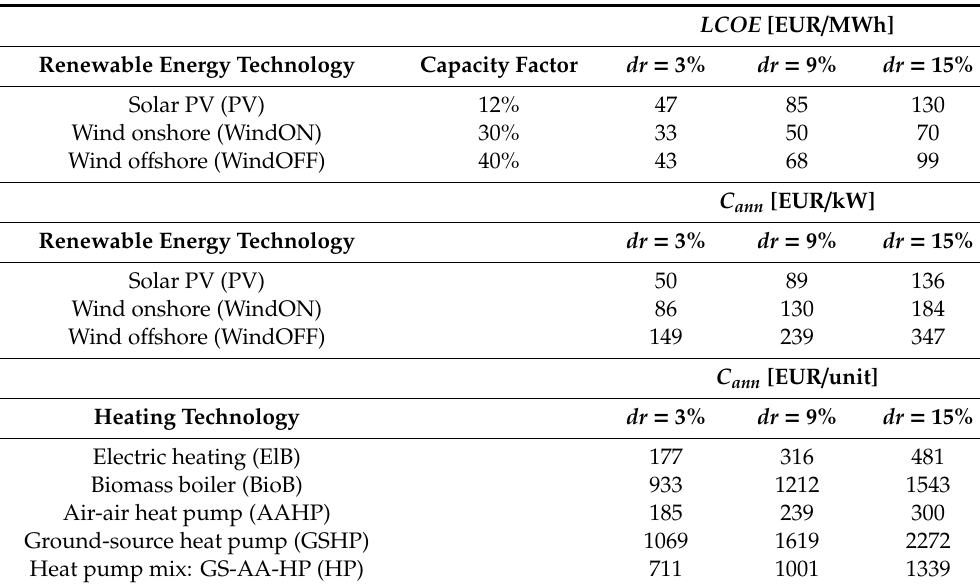
Table 3. LCOE , C ann for PV, WindON, and WindOFF; C ann for ElB, BioB, and HP (calculations based on 2020 technology cost parameters as provided by the EnergyPLAN cost